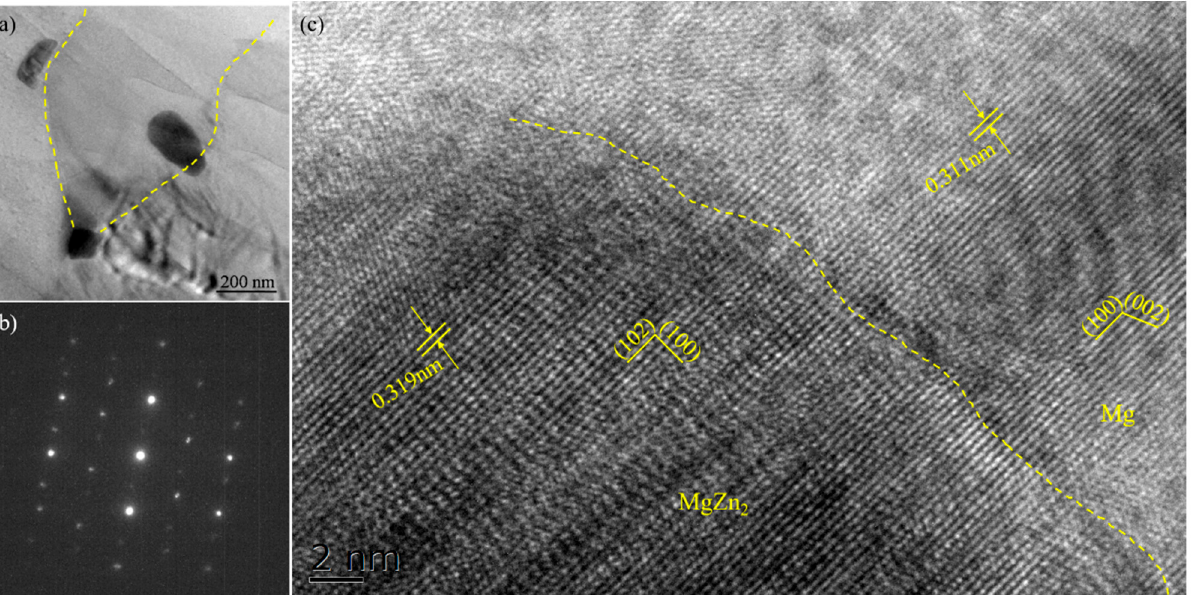
Figure 14. ( a ) TEM morphology, ( b ) HRTEM map and ( c ) diffraction pattern of the precipitate in the SiC p /Mg-5Zn material with a compression strain of 0.1.